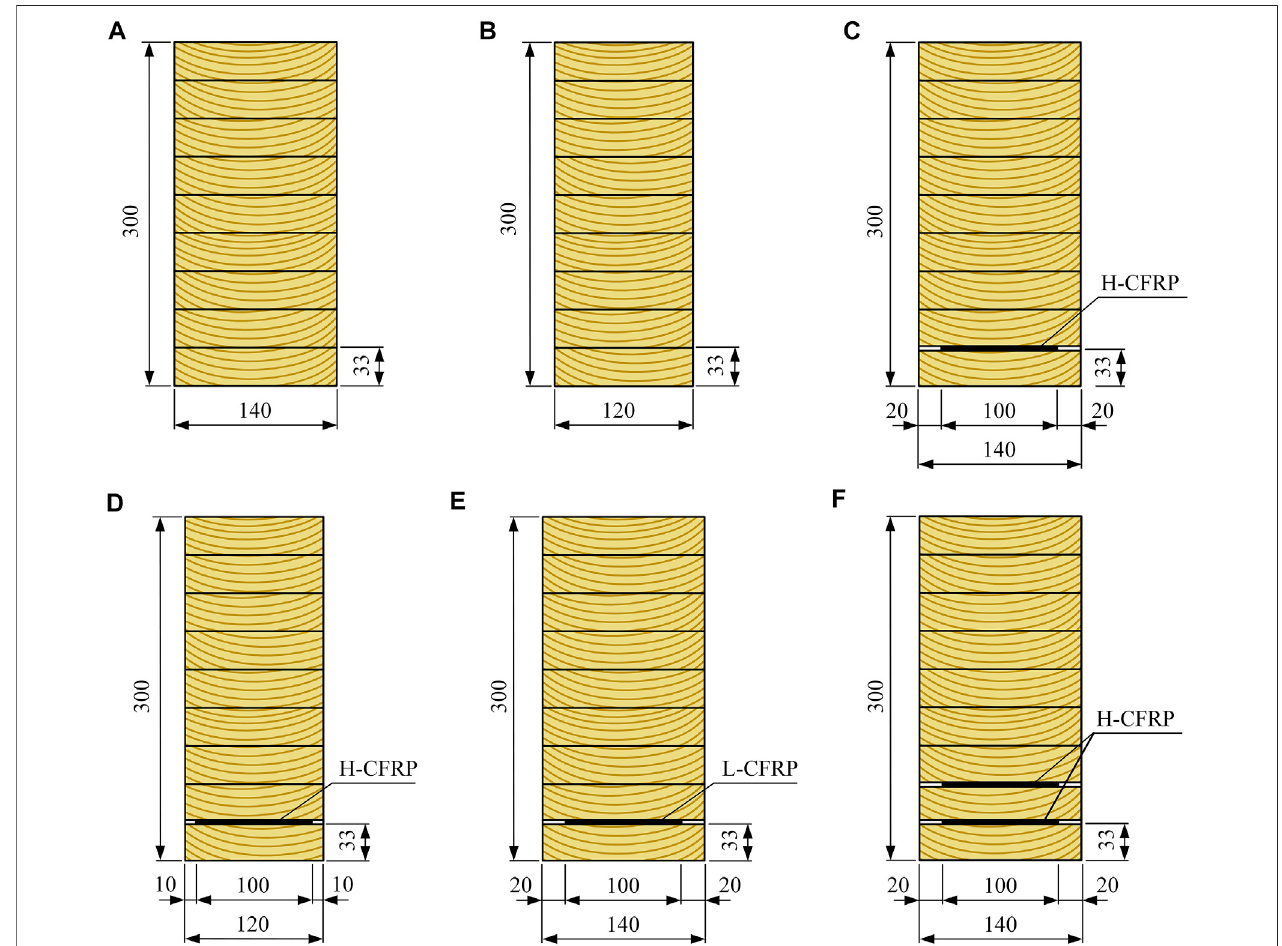
FIGURE 1 | Cross sections of specimens: (A) group W; (B) group N; (C) group WH; (D) group NH; (E) group WL; and (F) group WH+H.